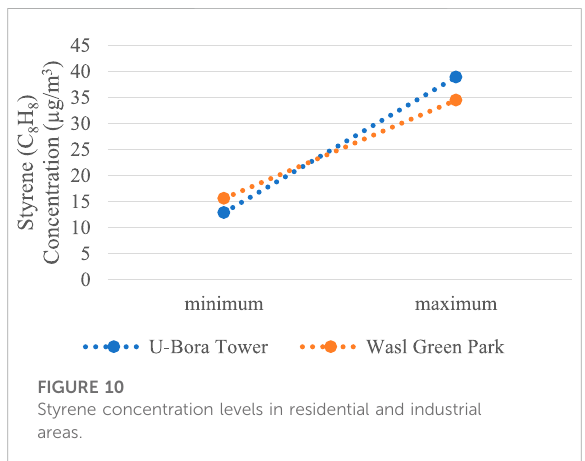
FIGURE 10 Styrene concentration levels in residential and industrial